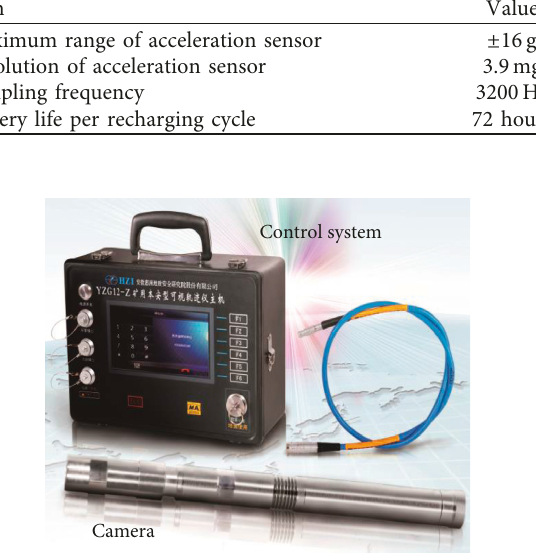
Figure 4: Borehole camera